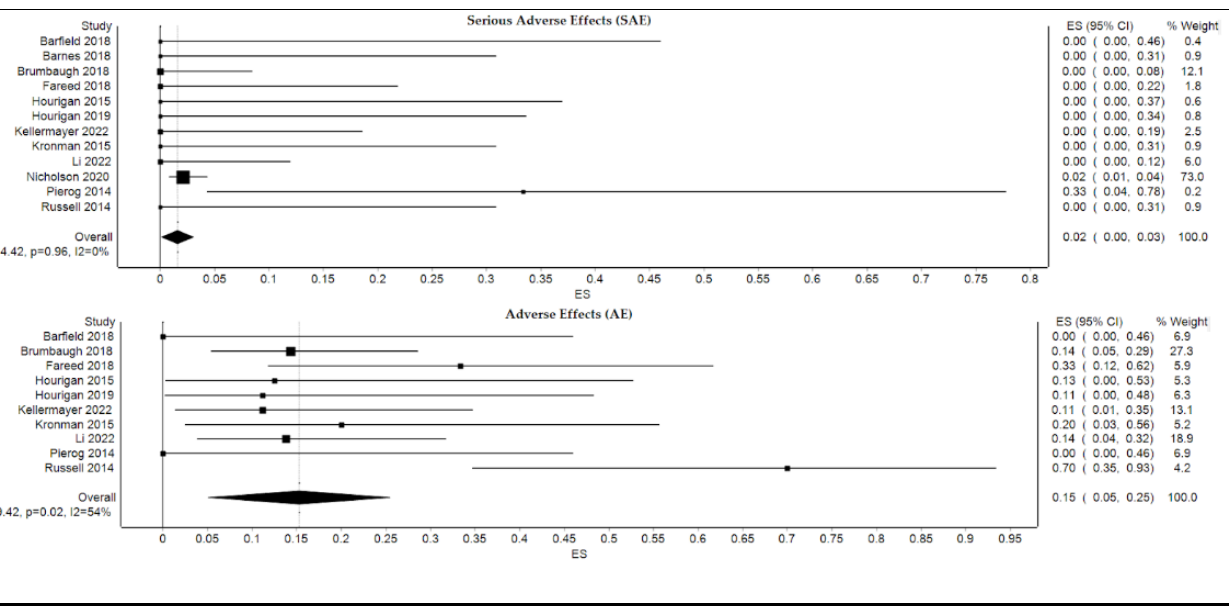
Figure 4. Forest plot displaying pooled rates of serious adverse events and adverse events of FMT.